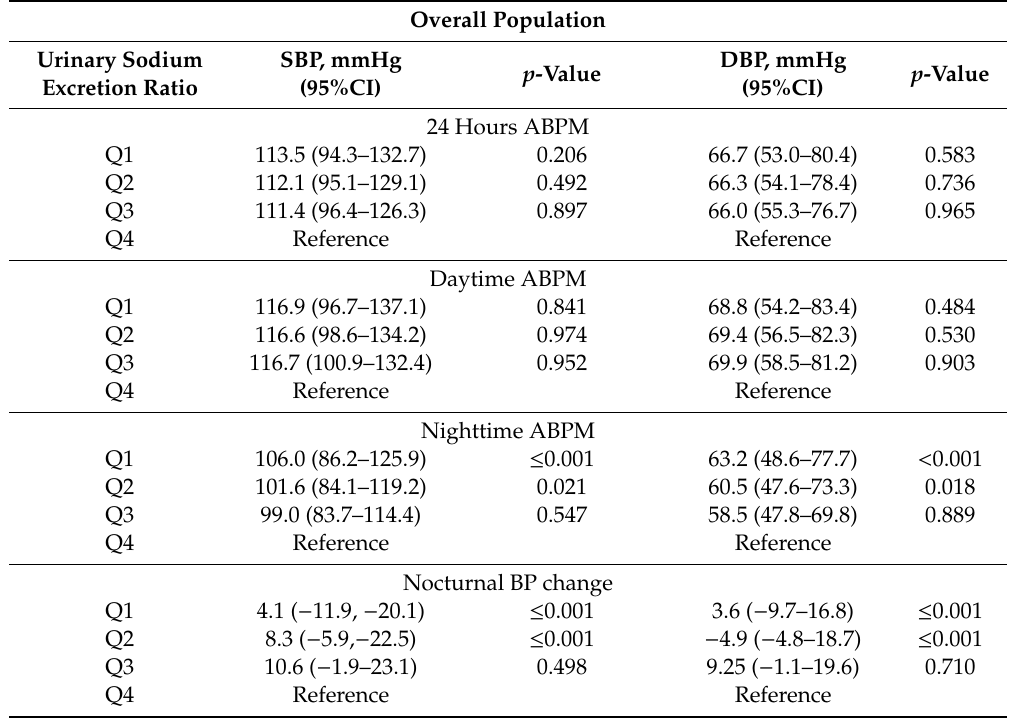
Table 2. Association between ambulatory blood pressure parameters (24-h, daytime and nighttime), nocturnal change and daytime / nighttime urinary sodium excretion ratio by quartiles.